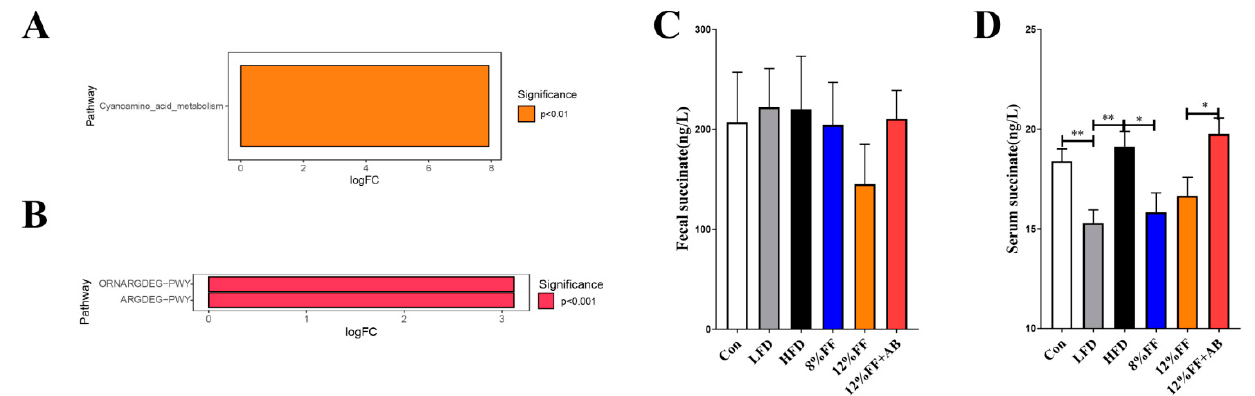
Figure 7. Effects of functional fiber on the metabolic function of gut microbiota in obese mice. ( A ) KEGG function prediction result. ( B ) MetaCyc function prediction result. ( C ) Succinic acid concentration in feces ( n = 7). ( D ) Succinic acid concentration in serum ( n = 7). The results are shown as the mean ± standard error ( n = 7). Significant differences are expressed as * ( p < 0.05), and extremely significant differences are expressed as ** ( p < 0.01).